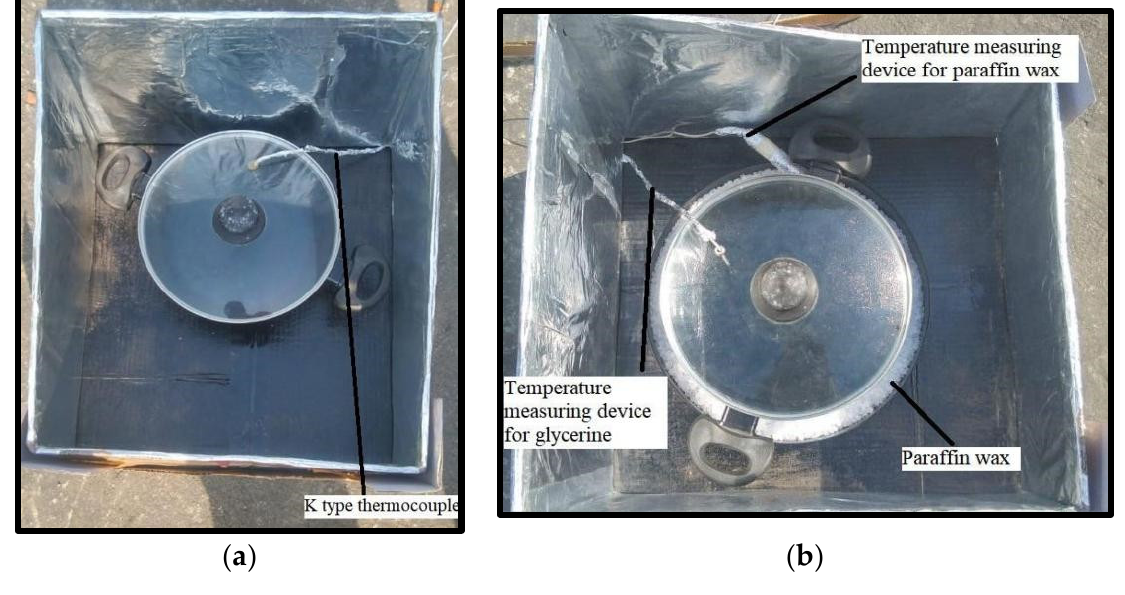
Figure 5. ( a ) Experimental setup on day 1 without the paraffin wax. ( b ) Experimental setup on day 3 when paraffin wax is used to collect data to find improvement in the thermal efficiency. The transparent lid of the solar cooker is placed on the top of the box, and then, the funnel of the solar cooker is placed on top of the box, as shown in Figure 6.